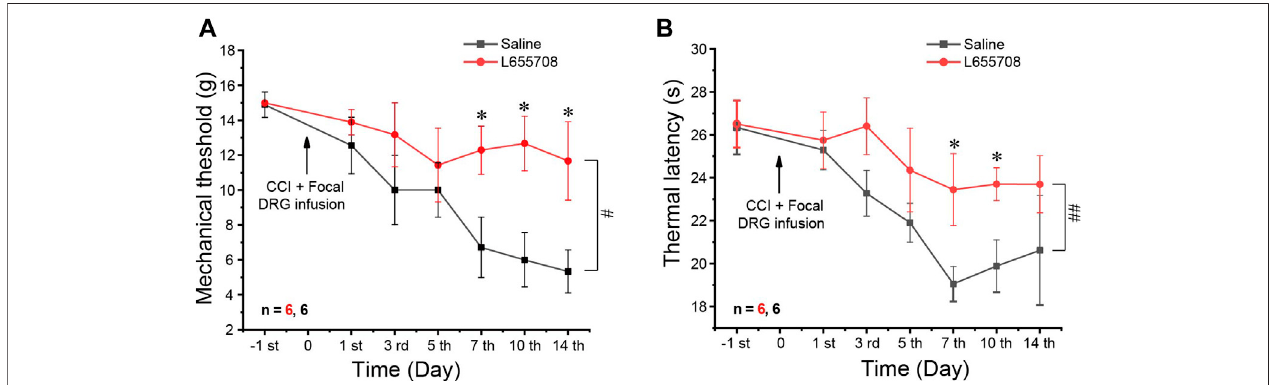
FIGURE 6 | Focal infusion of the α 5 GABAA subunit antagonist alleviates neuropathic pain in vivo . Focal DRG application of L655708 (20 μ M, ∼ 0.5 μ l/h) using an osmotic minipump signi fi cantlyalleviatedmechanical (A) and thermal (B) hyperalgesia produced bythe CCI. Repeated measures ANOVA withtheBonferronicorrection was used for comparison of hyperalgesia measurements between the groups, # p < 0.05, ## p < 0.01; one-way ANOVA was used for comparison within the corresponding time point: * p < 0.05. Number of experiments is indicated as n in each